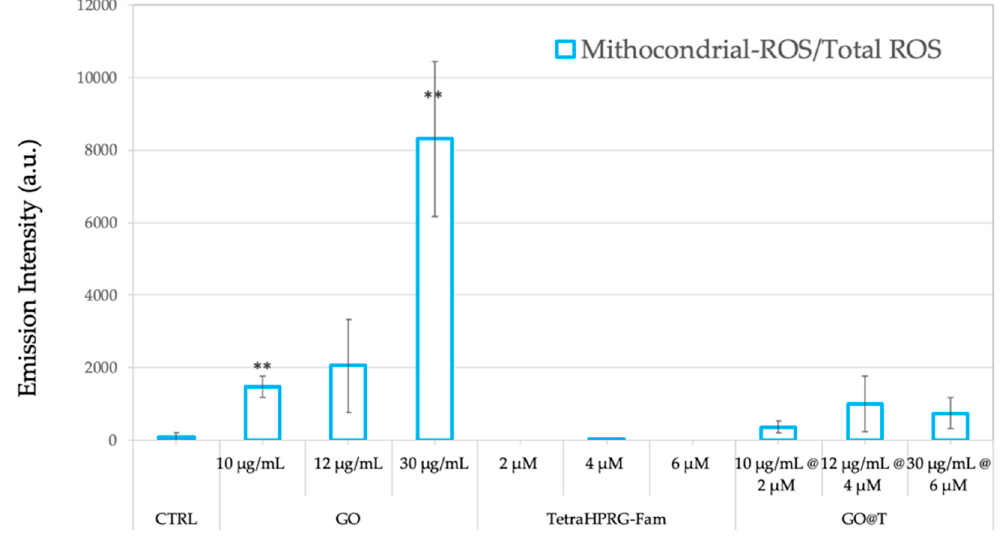
Figure 7. Ratio of mitochondrial-reactive oxygen species (ROS)/total-ROS levels measured on prostate cancer cells (PC-3) measured by the MitoSOX and dichlorohydrofluorescein (DCF) fluorescence assays. Cells were incubated for 24 h in absence (negative control, CTRL) or in presence of the different treatments: GO nanosheets (10, 12, 30 µg/mL), Tetra(HPRG)-Fam peptide (2, 4, 6 µM) and hybrid GO@T samples (10 µg/mL-2 µM, 12 µg/mL-4 µM, 30 µg/mL-6 µM of GO-peptide concentration). Values (means ± SEM) are from three independent experiments. Statistical analysis was performed by One-way ANOVA test. Symbols indicate the significance versus CTRL: * * p < 0.01. Results are expressed as ratio of MitoSOX with respect to DCF emission intensities.